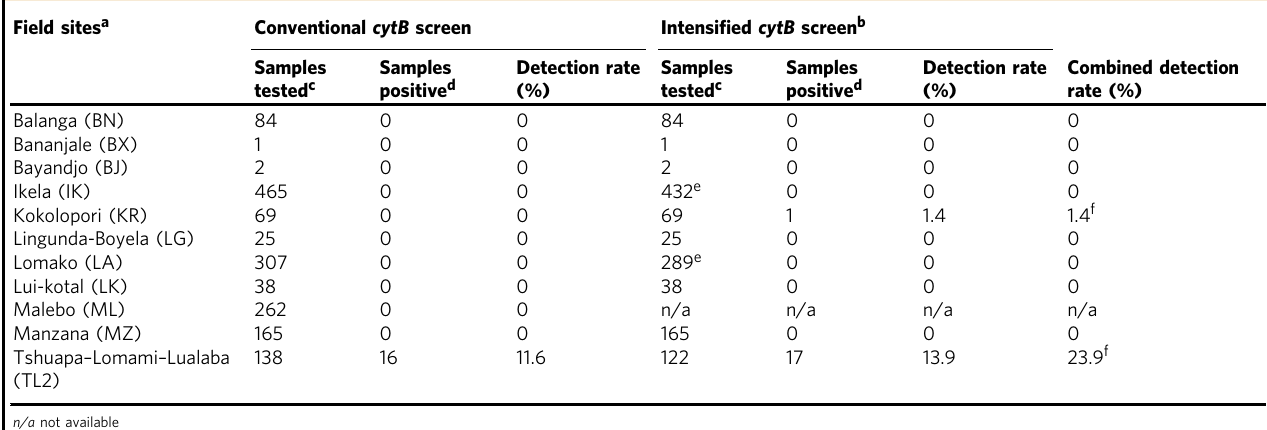
Table 1 Noninvasive screening of wild-living bonobo communities for Laverania infections